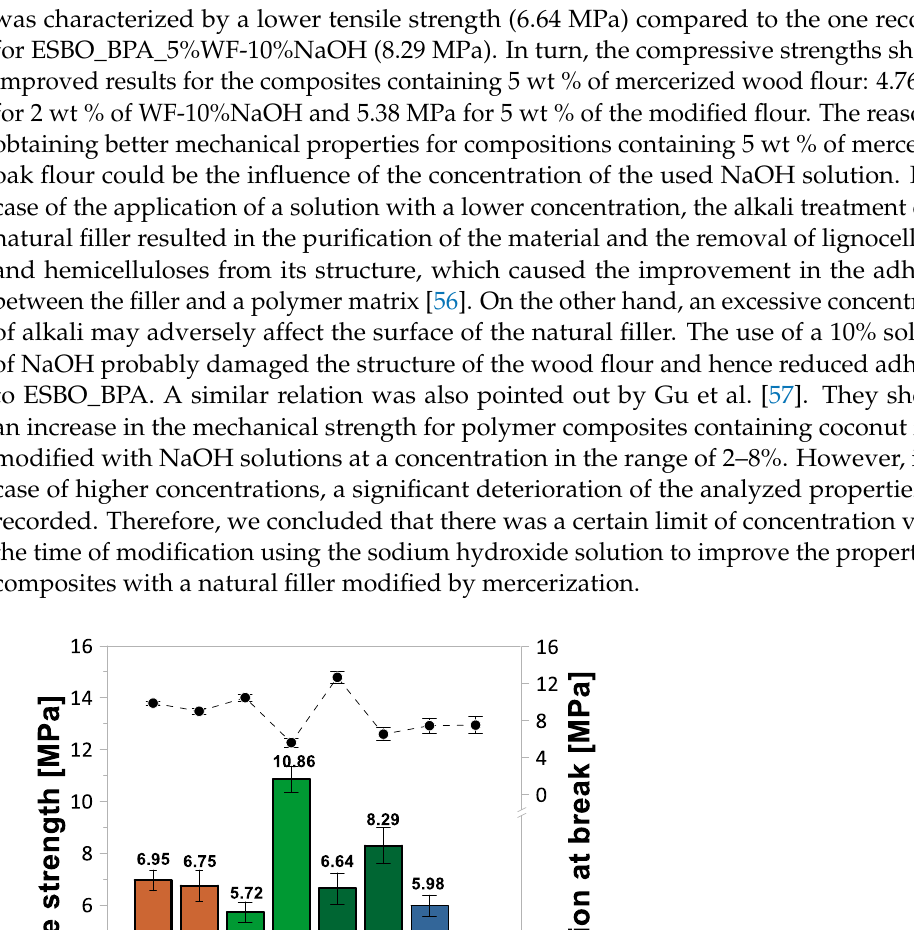
Figure 6. Flexural strength and deflection of compositions based on ESBO_BPA filled with waste oak flour.